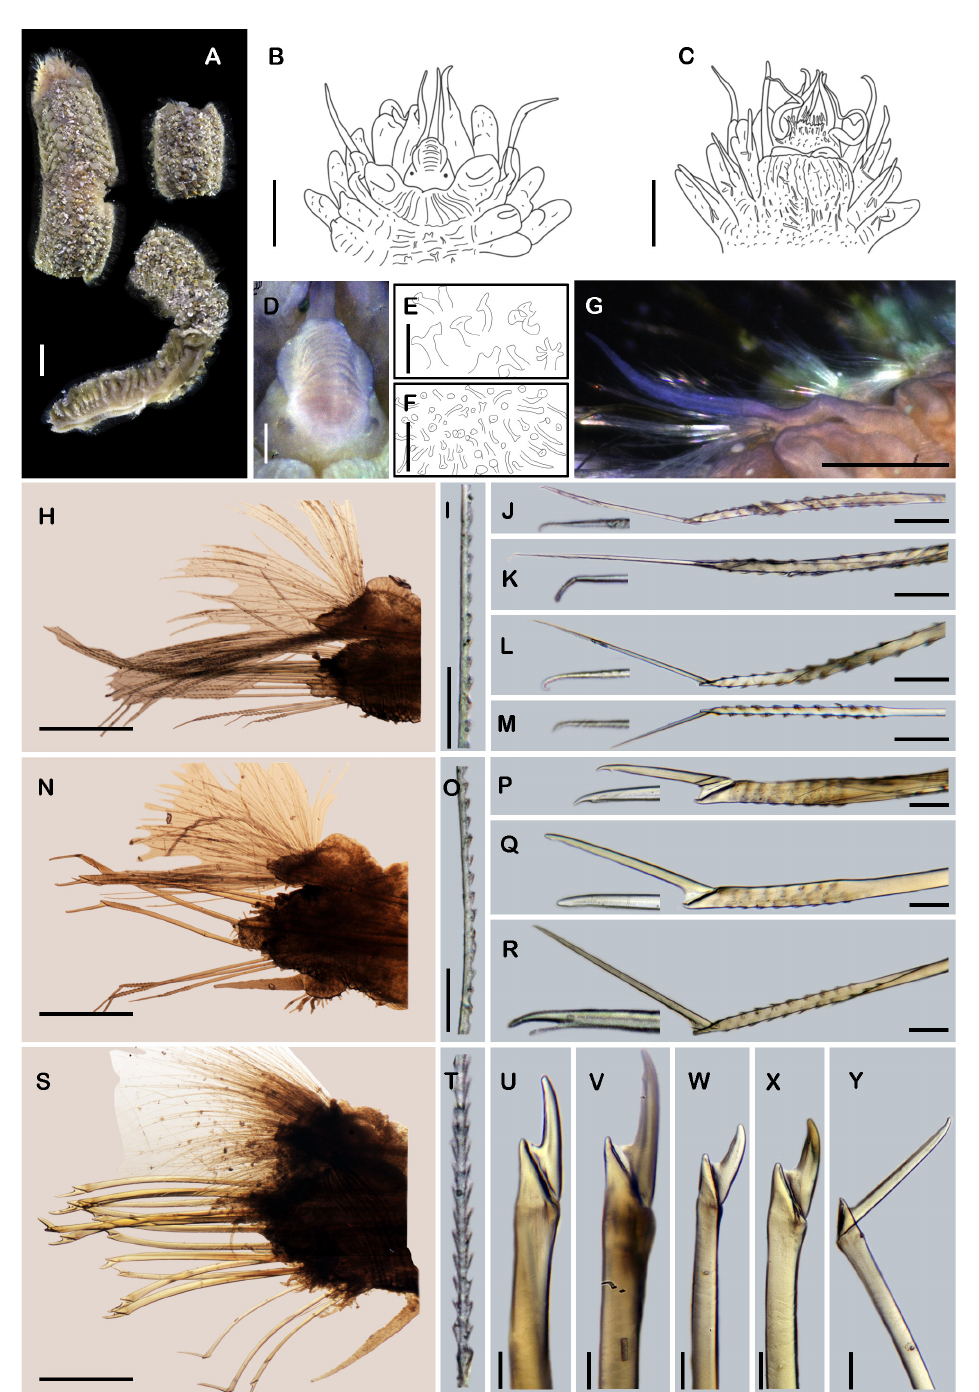
Fig. 15. Pelogenia hartmanae Pettibone, 1997, non-type specimen (UMML 7101-1369). A . Incomplete fragmented worm, dorsal view. B . Anterior end, dorsal view. C . Anterior end, ventral view. D . Detail of median antenna ceratophore. E . Dorsal papillae (close-up in box). F . Ventral papillae (close-up in box). G . Right cirrus from segment III. H . Right parapodium from segment II. I . Notochaeta from same. J . Unit A. K . Unit B. L . Unit C. M . Unit D. N . Right parapodium from segment III. O . Notochaeta from same. P . Unit A. Q . Unit B. R . Units C and D. S . Right parapodium from segment 26. T . Notochaeta from same. U . Unit A. V . Unit B. W . Unit C. X . Subunit 1. Y . Unit D. Scale bars: A = 2 mm; B–C = 1 mm; D = 50 µm; E–F = 20 µm; G–H, N, S = 500 μm; I, O, T = 40 μm; J–M, P–R, U–Y =